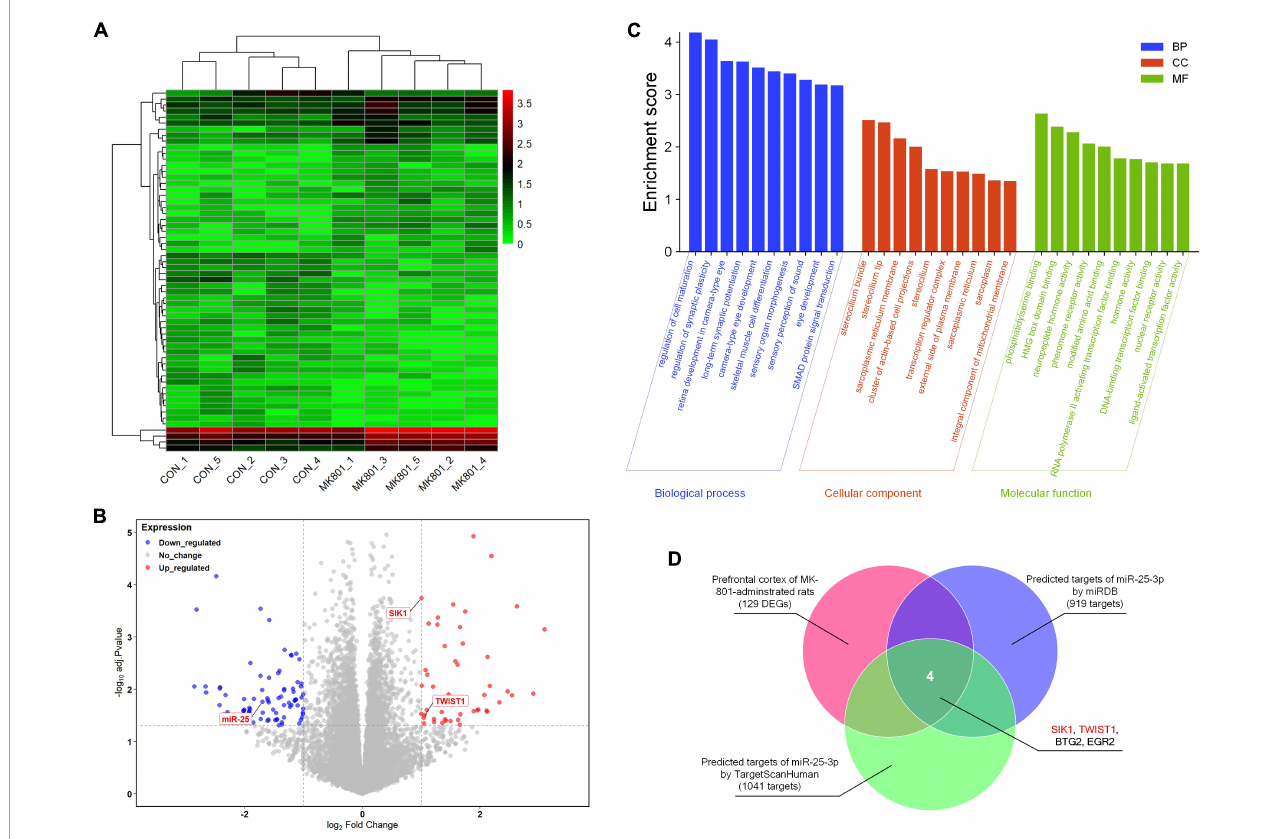
FIGURE1 RNA-seq analysis of the differentially-expressed genes in the prefrontal cortex. (A) Heatmap of the differentially-expressed genes. (B) Volcano plot of the differentially-expressed genes. (C) Gene Ontology (GO) enrichment analysis of the differentially-expressed genes. (D) Venn diagram of the genes that might be associated with schizophrenia and also are potential targets of miR-25-3p.